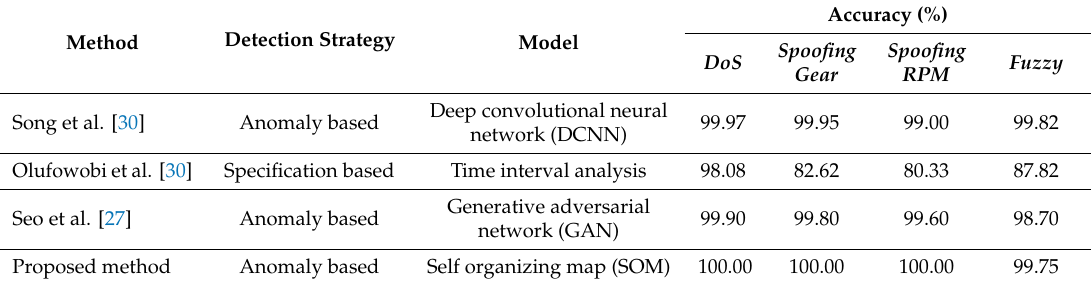
Table 8. Comparison between the XYF–K algorithm and the methods previously studied.